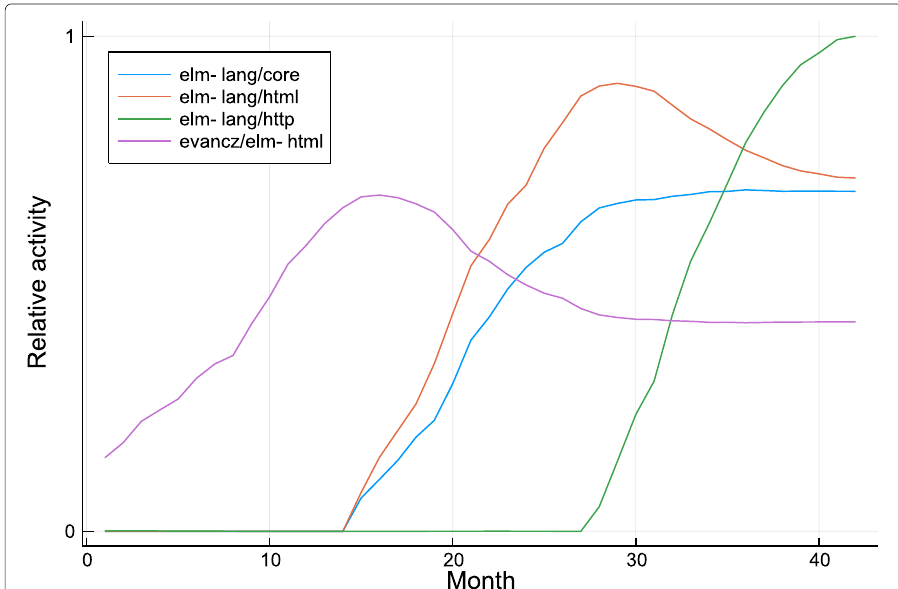
Fig. 13 PyPI community activity. Relative activity of each community in each month. The communities are named by important packages as detailed in the “Methods” section The general rule is “up and to the right”: all of the ecosystems we considered increased in activity as time went on, in agreement with Decan et al. (2018). This is unsurprising as it is relatively rare for a package to lose dependencies—it can fall out of use, but the packages that previously depended on it will tend to continue to depend on it.